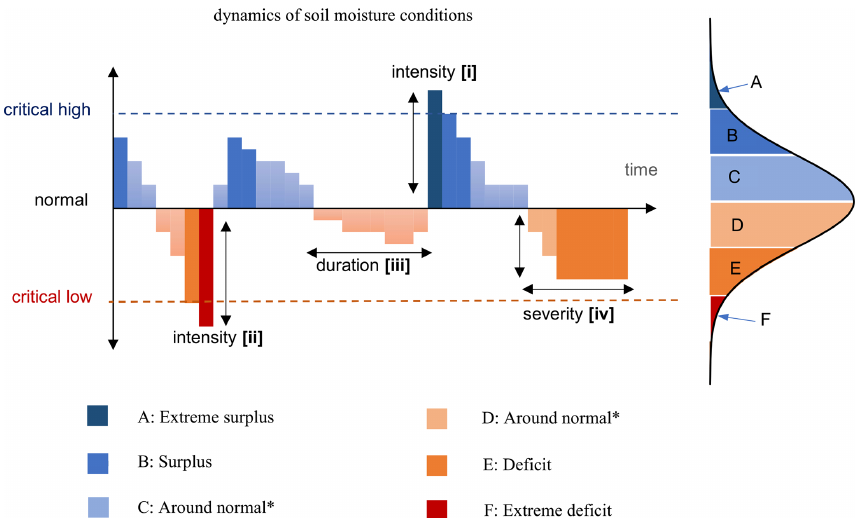
Figure 1. Soil moisture dynamics within a typical growing season. Some soil moisture conditions can be harmful to crops, including excess wetness (i), moisture stress intensity (ii), duration of moisture stress (iii), and severity of soil moisture stress (iv). The around normal ( ∗ ) levels can be determined by statistically examining the impacts of various intervals of soil moisture deviation from normal (seasonal mean volumetric soil